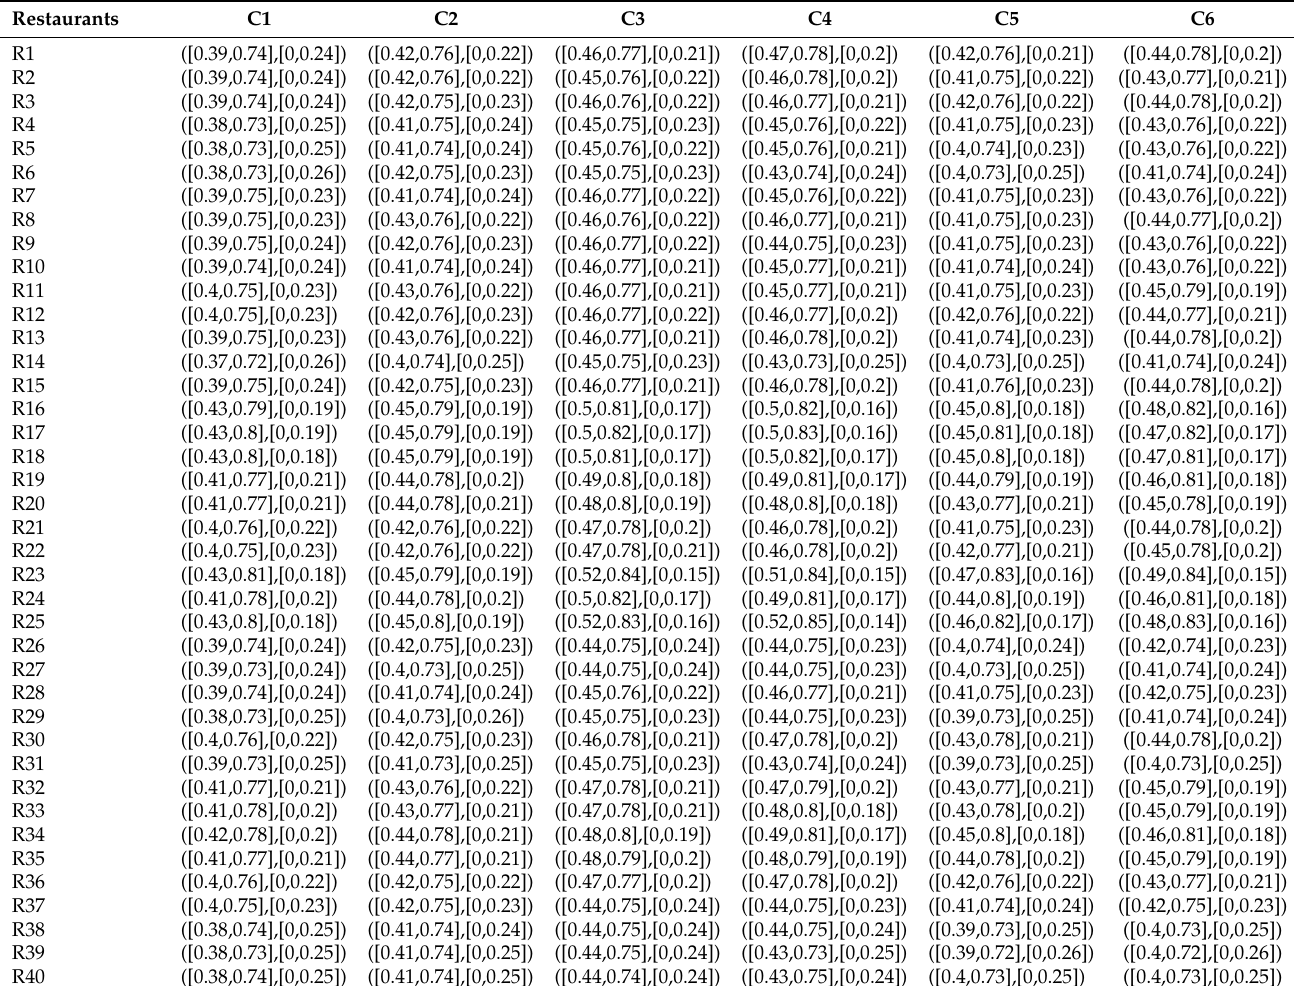
Table 13. The weighted IVIF dataset for the evaluation of restaurants.